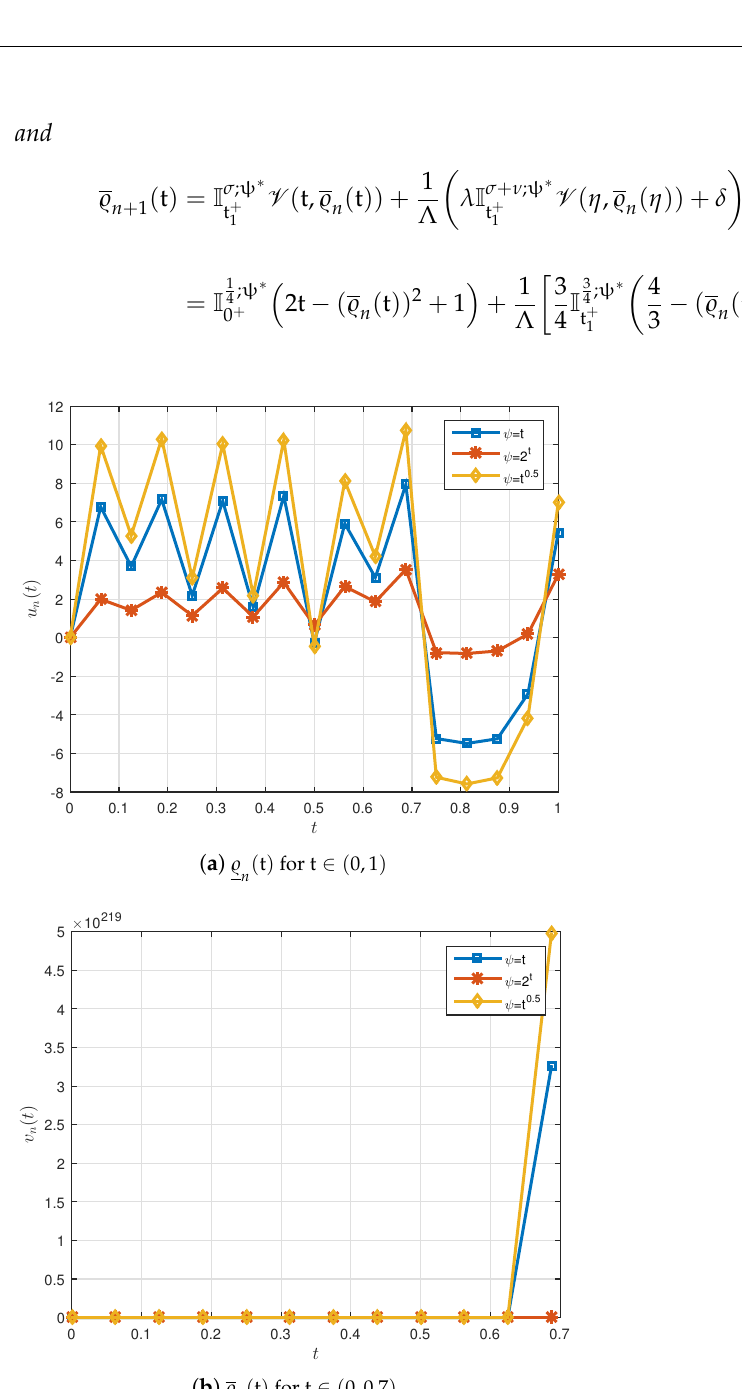
( t ) and (cid:36) ( t ) in ( a ) and ( b ) respectively for the ψ ∗ n √ n ( t ) = t Katugampola derivative (for ρ = 0.5) in 3